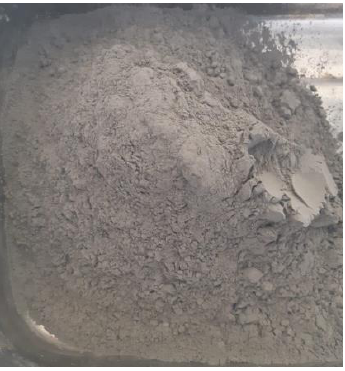
Figure 5. Class F fly ash used in this study.